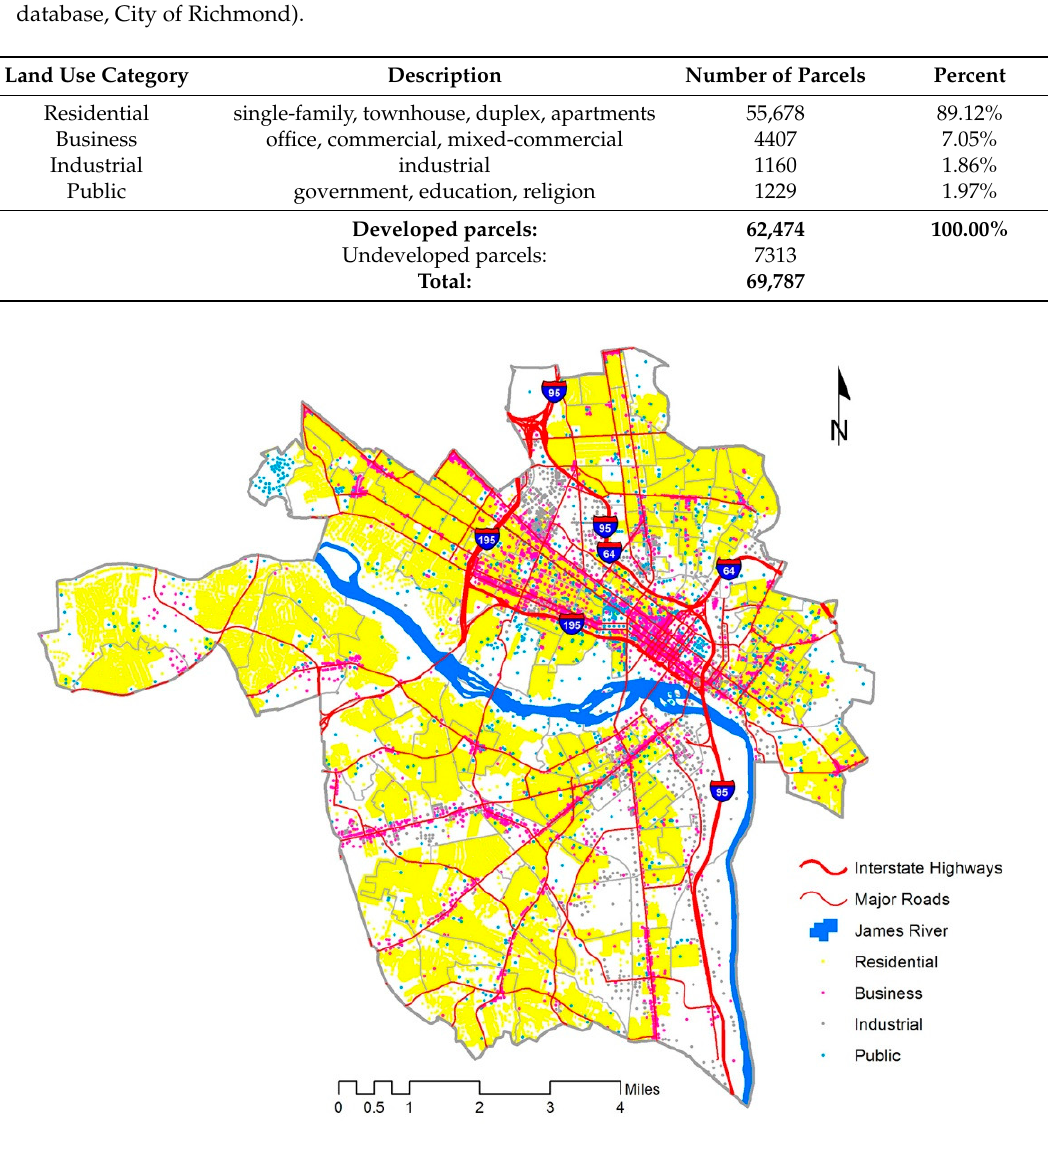
Figure 3. City of Richmond land uses—residential, business, industrial, and public. (Author’s